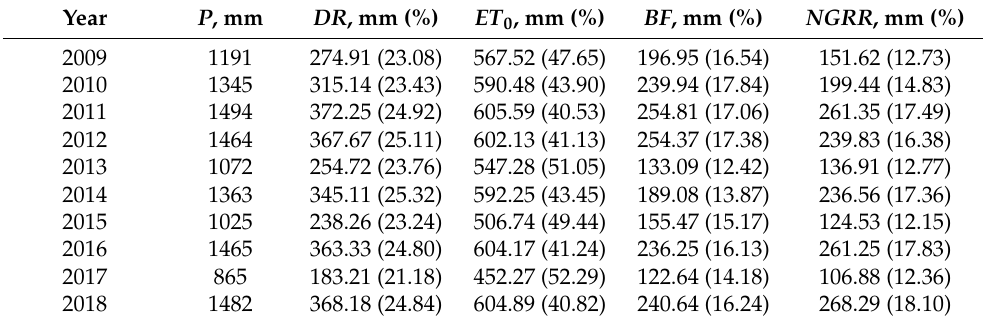
Table 2. Estimated NGRR , DR , ET 0 , and BF of the Nakdong River watershed, with the ratios (%) to the annual average precipitation ( P ) during